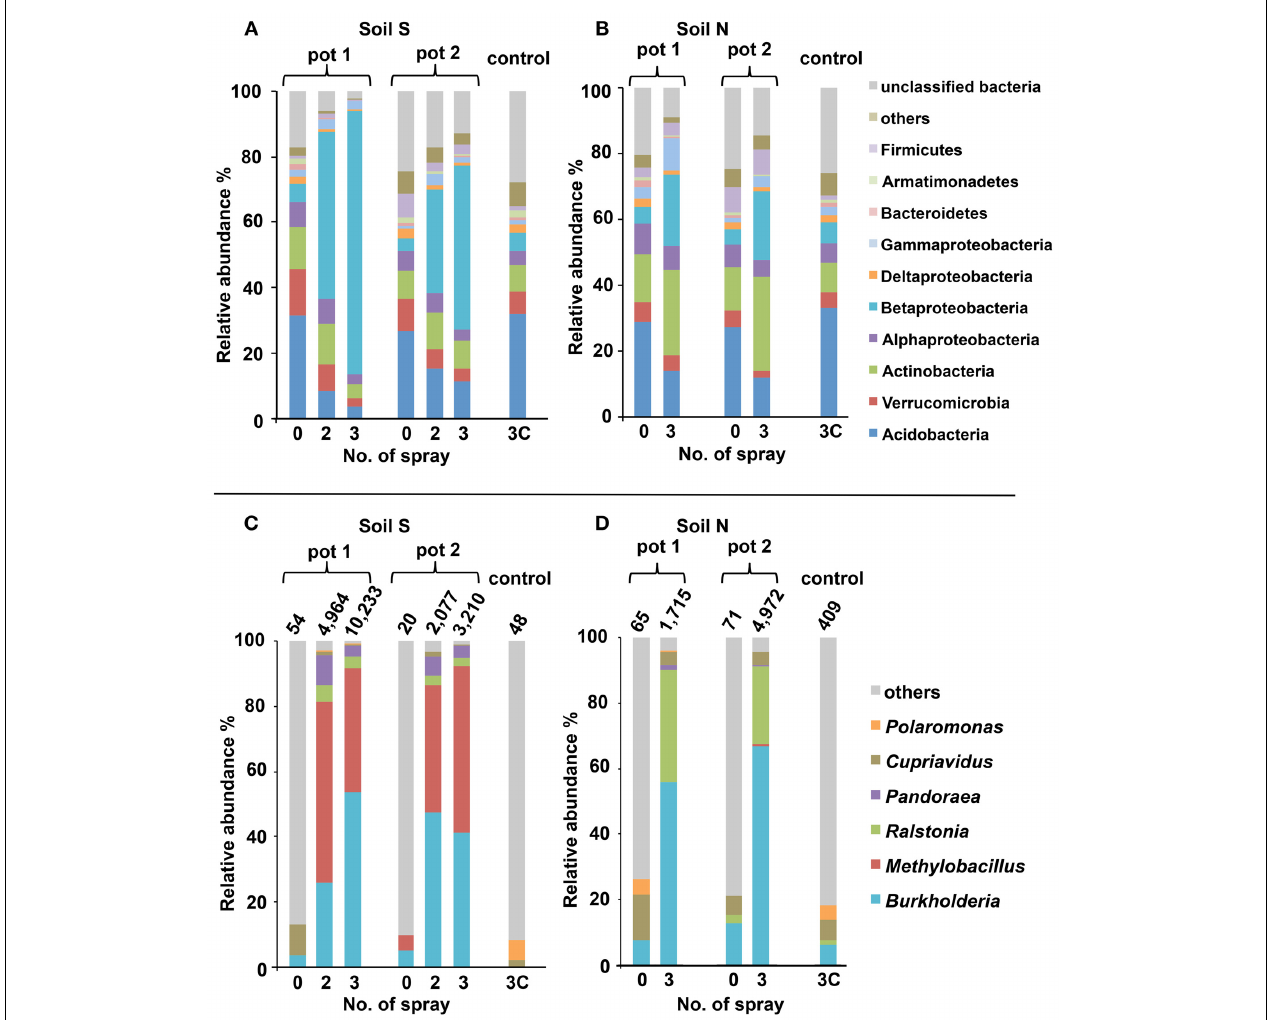
FIGURE 3 | Structural changes of microbial communities in MEP-sprayed soils. Soil S (A,C) and soil N (B,D) were analyzed by deep sequencing of 16S rRNA gene. For each soil, results of replicated experiments (pot 1 and pot 2) are shown. Relative distributions of the sequences at (A,B) phylum-level (class-level in the Proteobacteria ) and